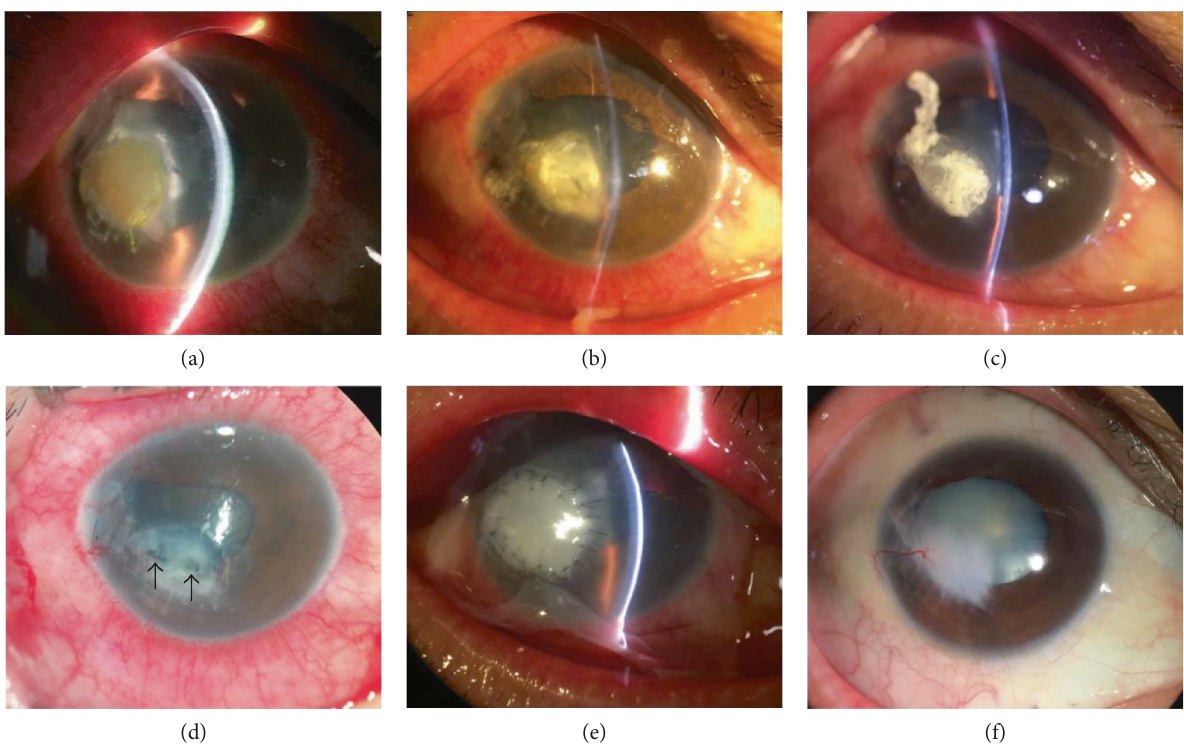
Figure 4: Reconstruction of the perforated cornea with fungal keratitis. Case number 8. A 46-year-old man su ff ered from severe ocular rupture in a trauma. One month after the suture of cornea, fungal corneal ulcer was observed (a). The ulcer area was gradually decreased at day 2 (b) and day 4 (c) after antifungal treatment. However, the anterior chamber became shallower (a, b, c). After removing the necrotic tissue, perforations were noted (d, arrows). The anterior chamber formed at postoperative day 1 (e). The cornea was successfully reconstructed, and a stable ocular surface without in fl ammation was achieved at the seventh month